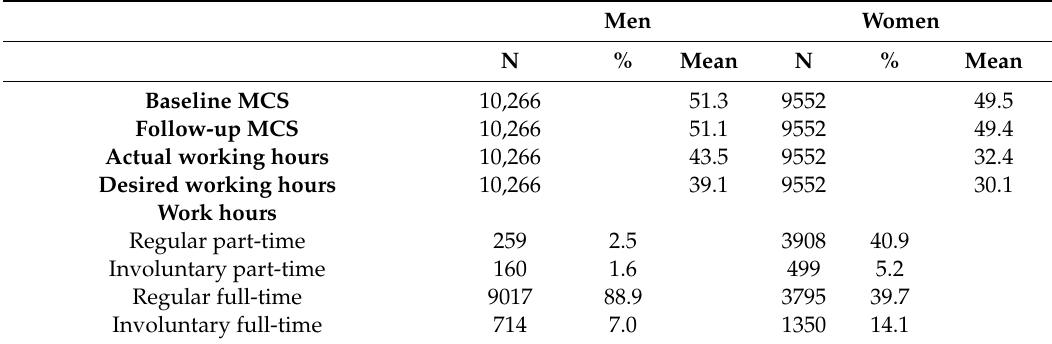
Table 2. Description (in %) of the population studied (Population in salaried employment, 20–60